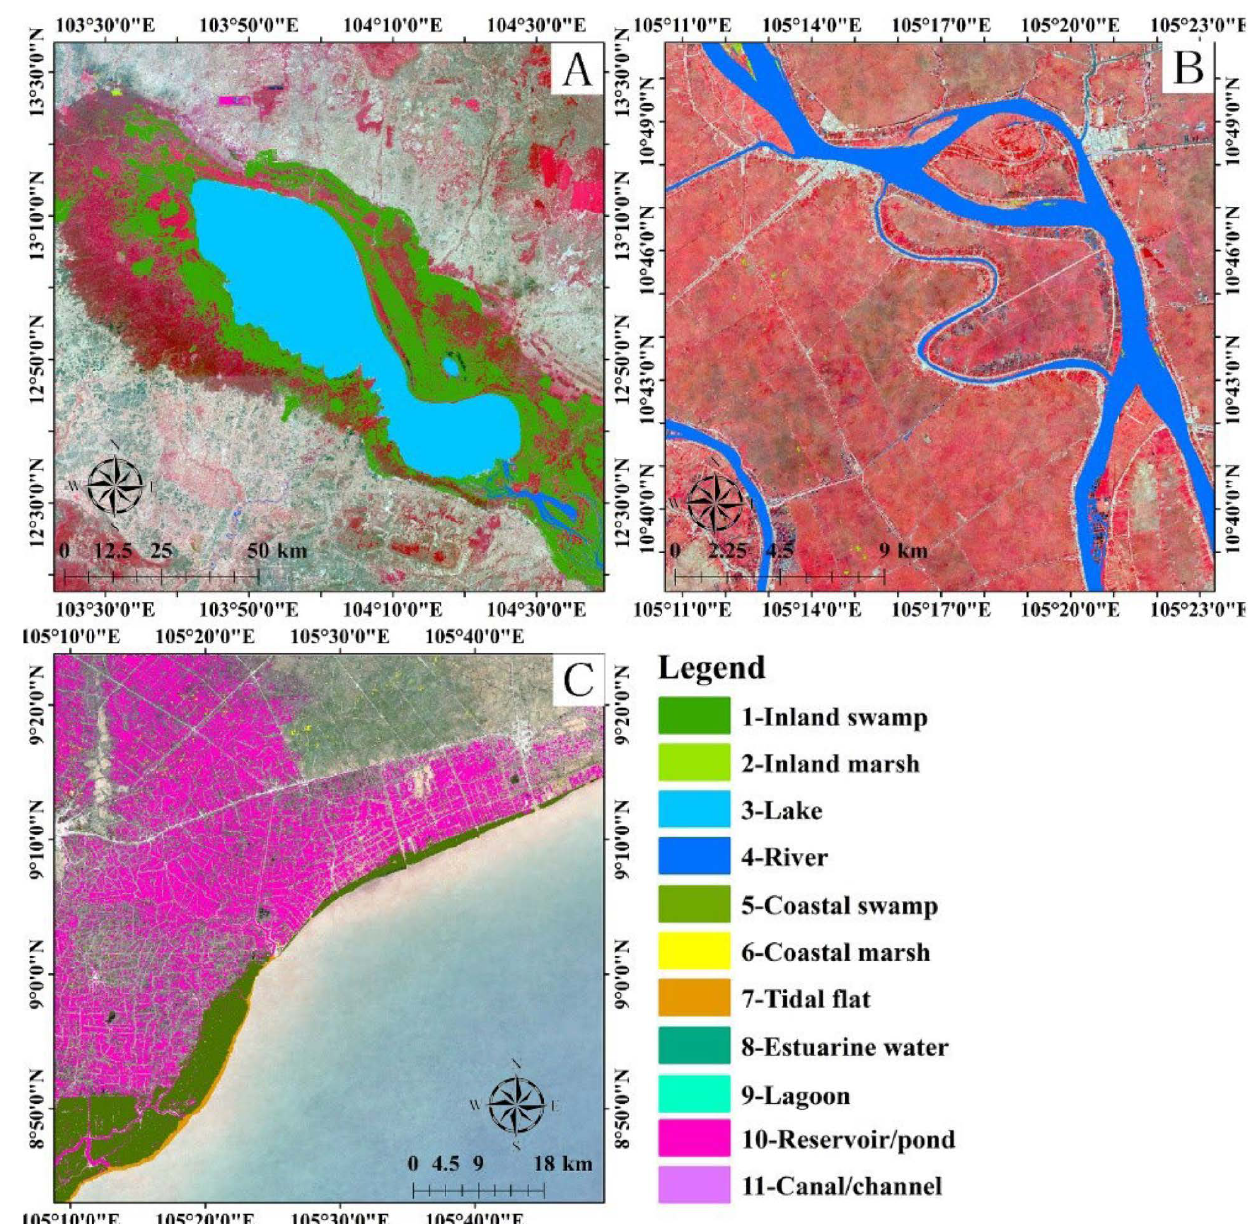
Figure 9. The mapping results. ( A ) Lake and inland swamp. ( B ) River. ( C ) Coastal swamp and